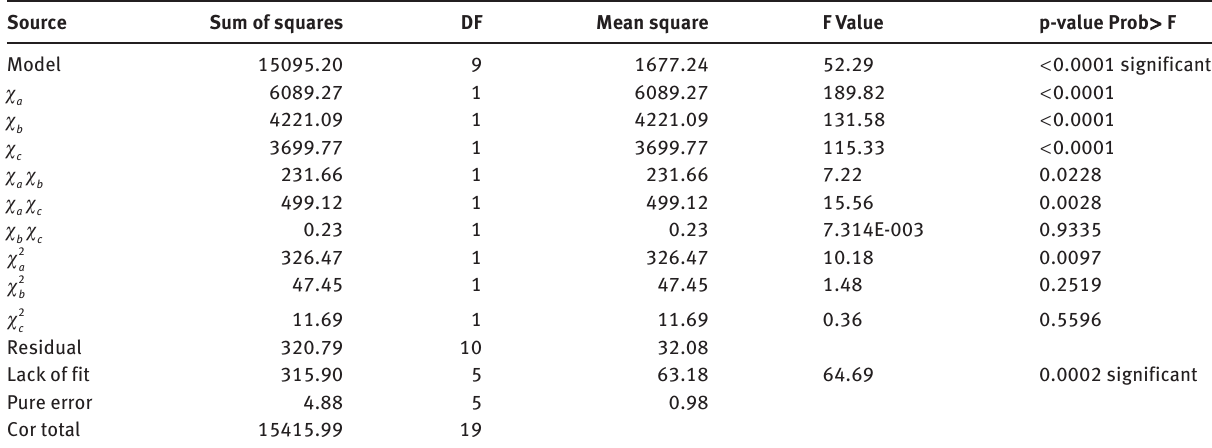
Table 4: ANOVA for response surface quadratic